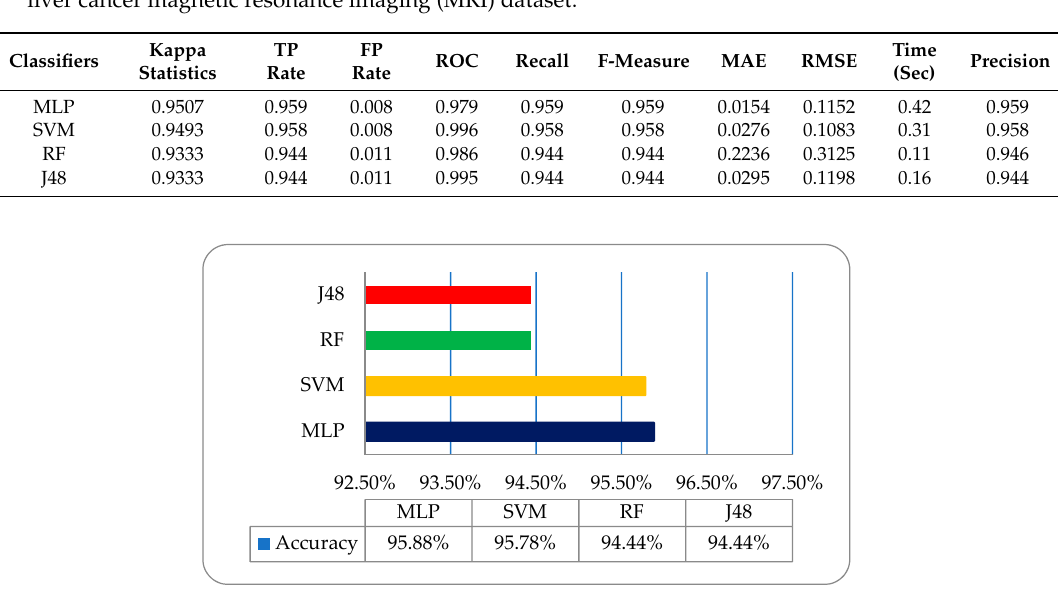
Figure 6. The overall accuracy graph of the employed ML classifiers on the MRI dataset.